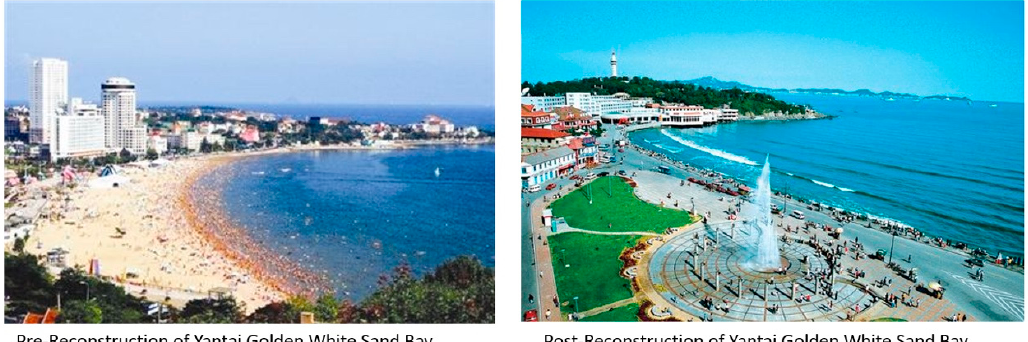
Figure 1. Pre- (2003) and Post-Reconstruction (2015) of Yantai Golden Withe San Bay (Yantai City Planning Exhibition Hall). In 2003, the natural shoreline of the sandy bay was replaced by a man-made plaza.